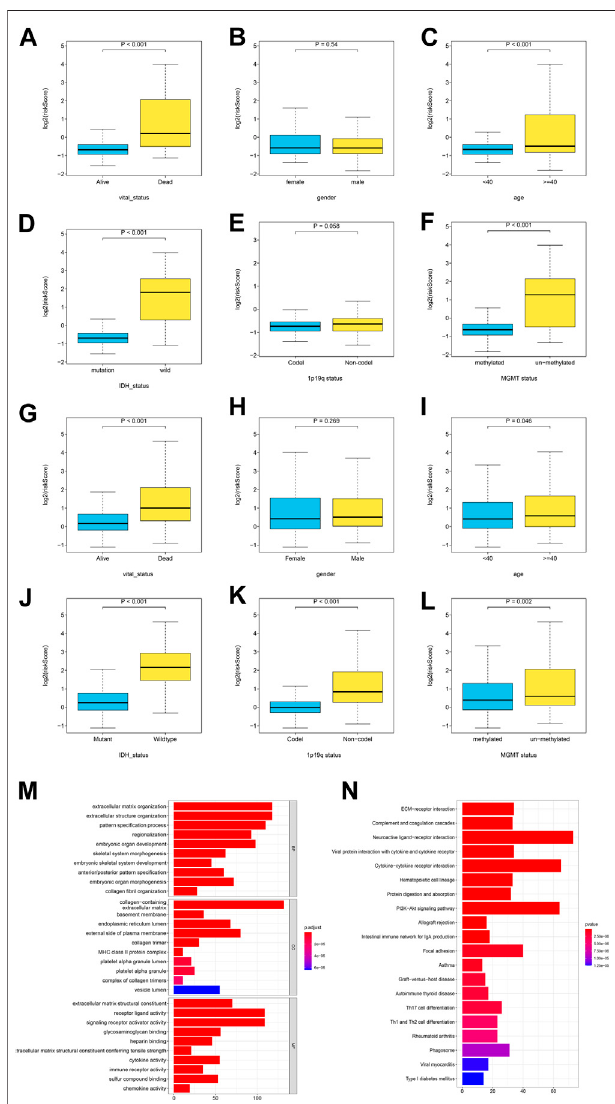
FIGURE 5 | The correlation between the log2 (GRS score) and clinicopathological features and pathway enrichment analysis. (A-F) Distribution of GRS scores in different subgroups in TCGA cohort, and (G-L) CGGAcohort. (M-N) GOandKEGGenrichmentanalysisfordifferentially expressed genes between the high- and low- GRS score